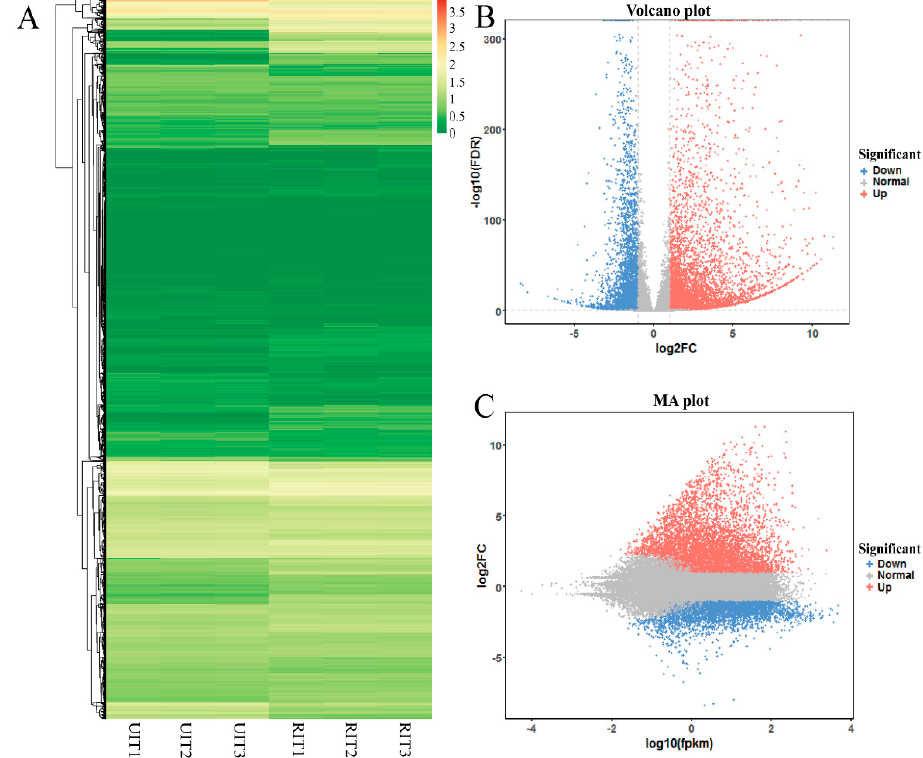
Figure 3. Expression analysis of the differentially expressed genes (DEGs) that were upregulated in RIT relative to UIT are shown in red, and downregulated genes are shown in green. ( A ) Cluster map of the DEGs in different biological replicates of RIT and UIT. Scale shows the log10 (FPKM+1) gene expression level in the sample; ( B ) DEG volcano plot; ( C ) DEG minus average (MA) plot.